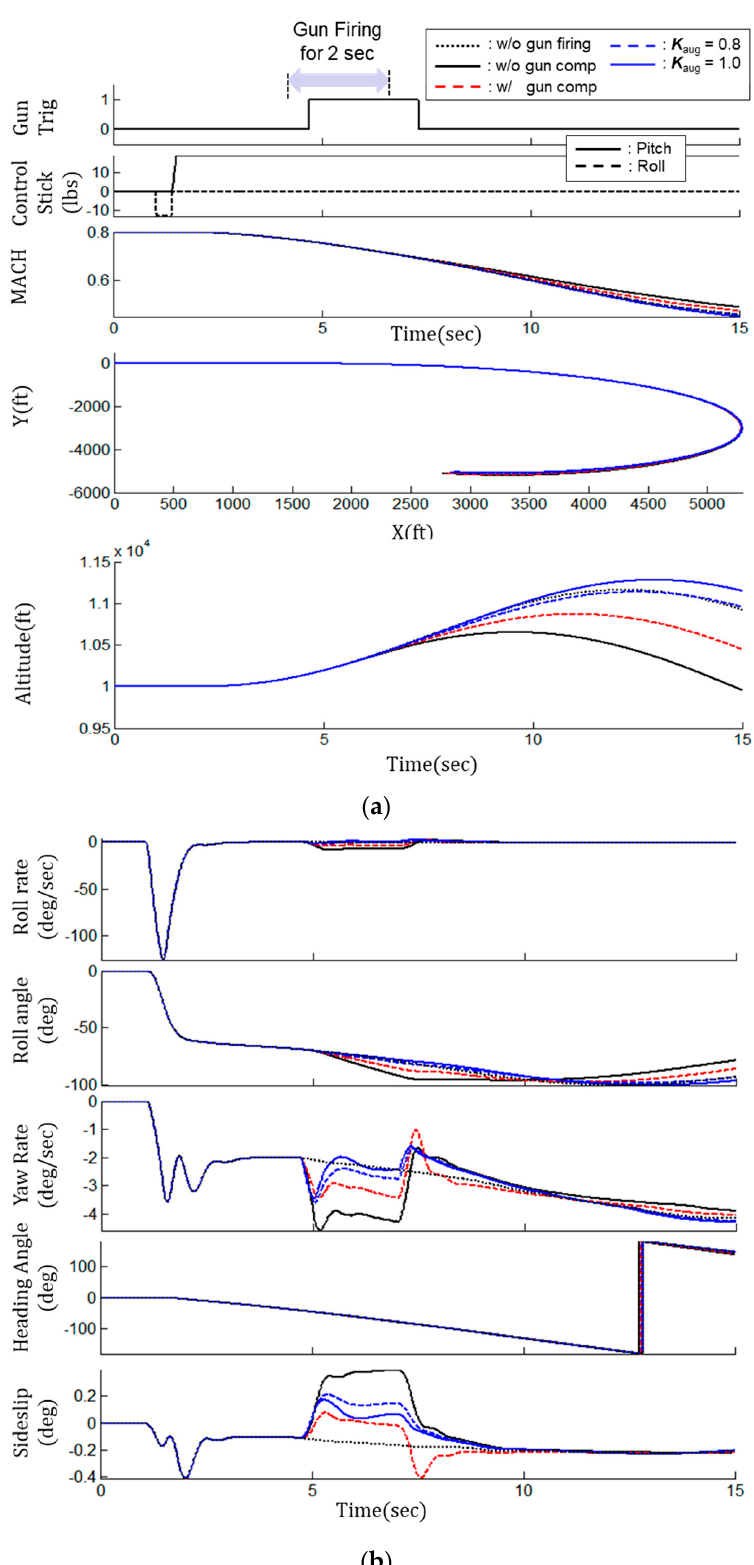
Figure 10. Result of simulation during gun firing for slow down turn maneuver at M0.8, 10 kft altitude: ( a ) aircraft trajectory; ( b ) transient